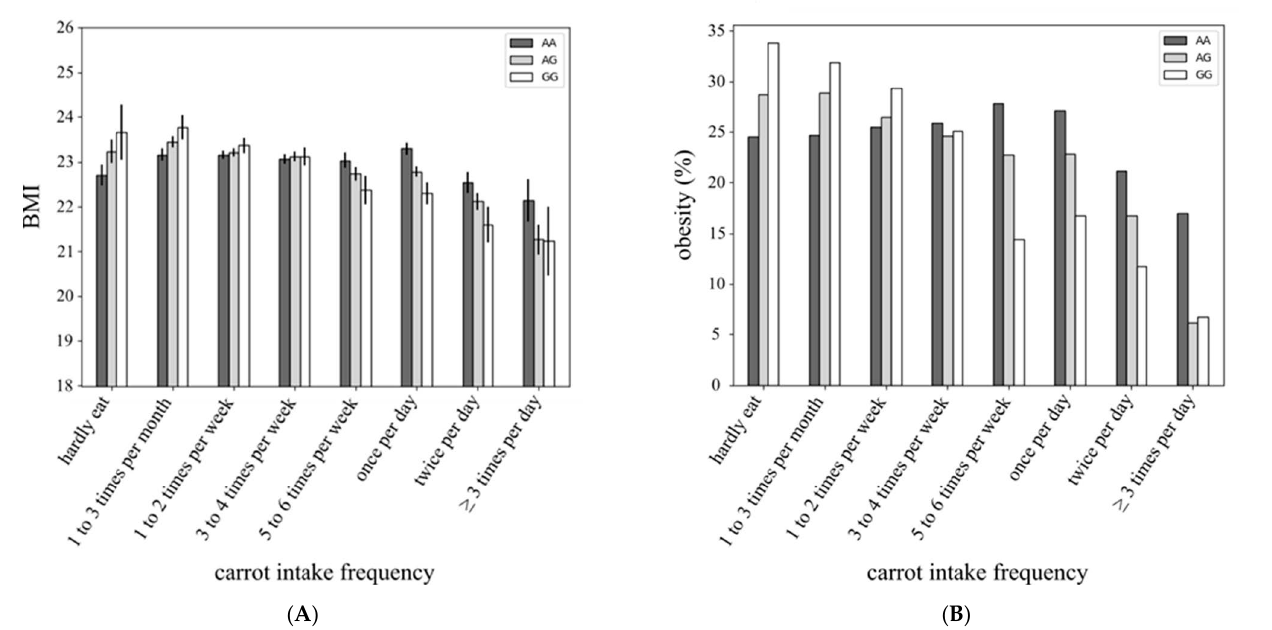
Figure 1. Interaction between rs4445711 and frequency of carrot intake on body mass index (BMI) ( A ) and obesity ( B ) in both men and women. Table 2. SNPs with suggestive levels of association ( p < 1 × 10 -5 ) with body mass index